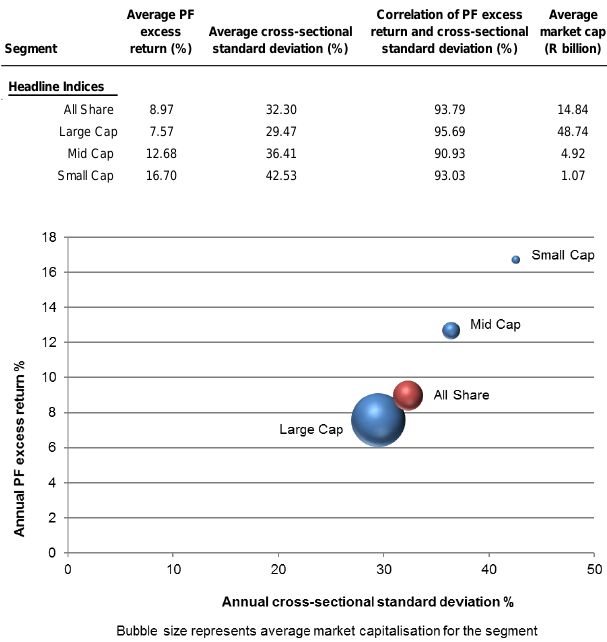
Figure 6: PF excess return and cross-sectional standard deviation for the headline